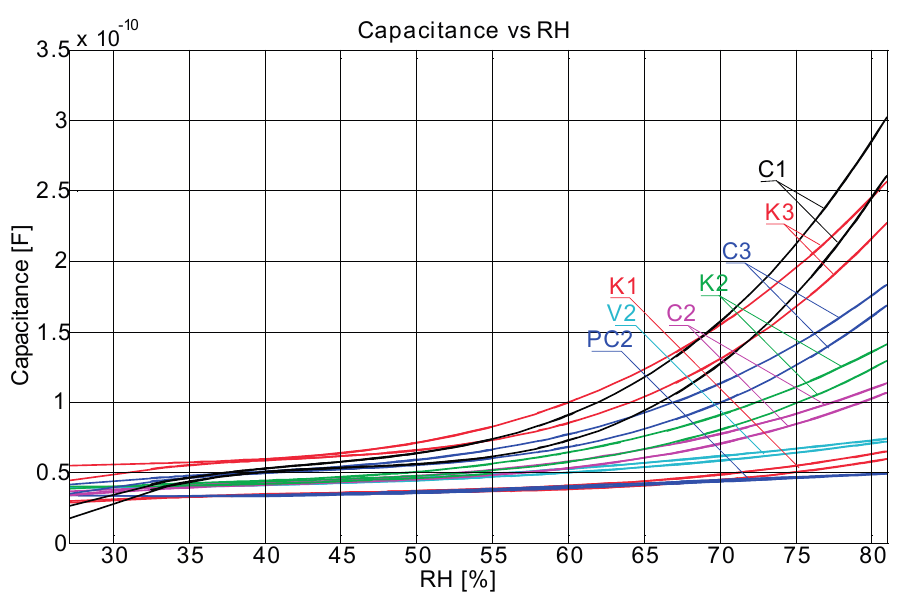
Figure 5. Capacitance vs. RH